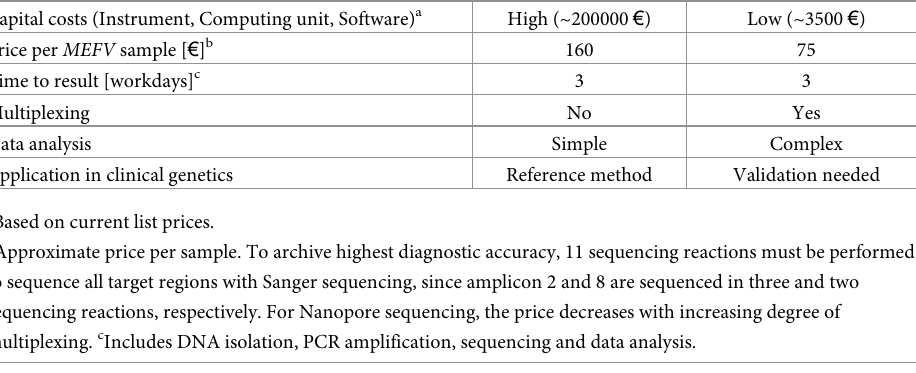
Table 2. Comparison of Nanopore and Sanger sequencing based on various aspects relevant for use in clinical diagnostics.